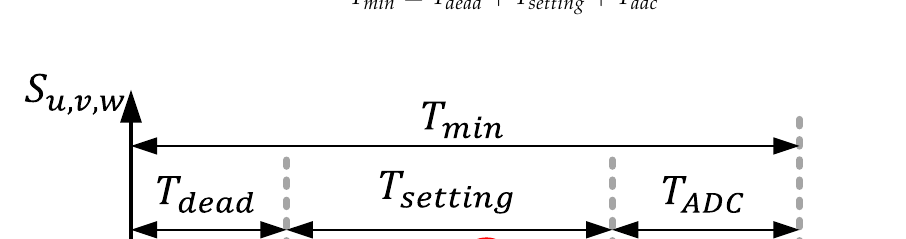
Figure 5. Configuration of the minimum time ( T min ) needed to detect current.